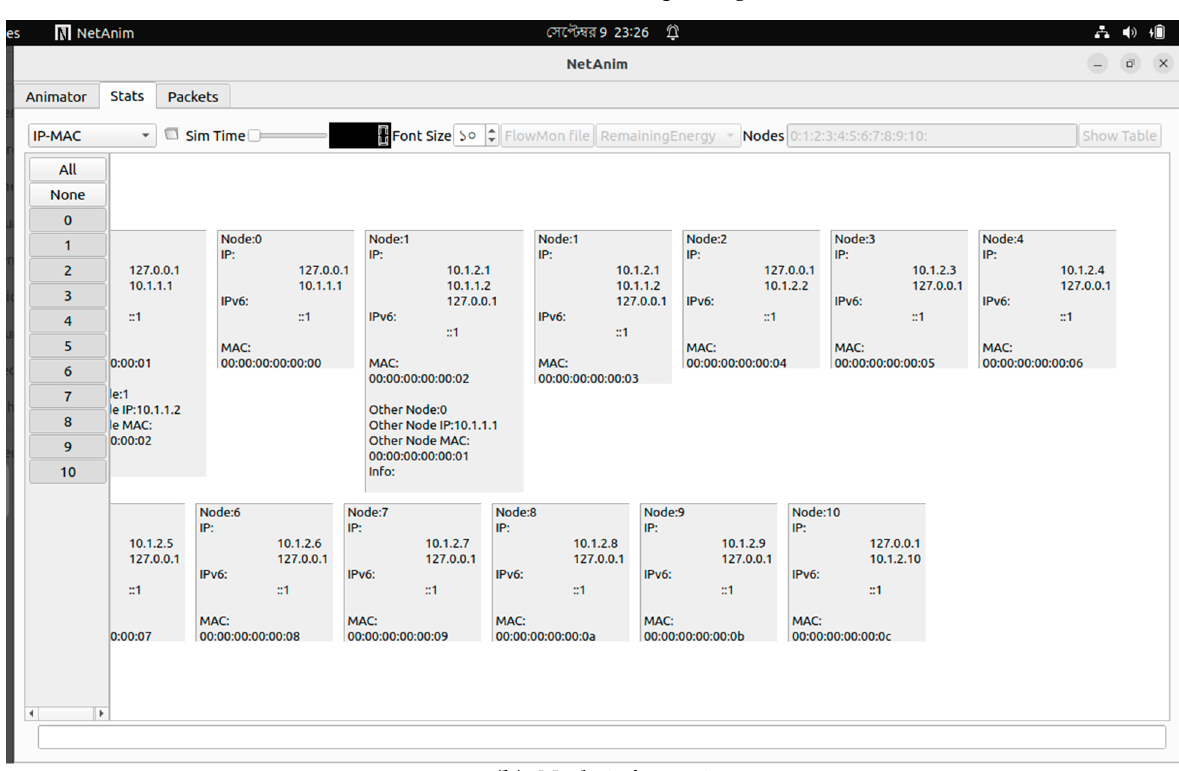
Figure 11. NS3 simulation from ULSM to HMS. (a)Packet data passing; (b)Node information.